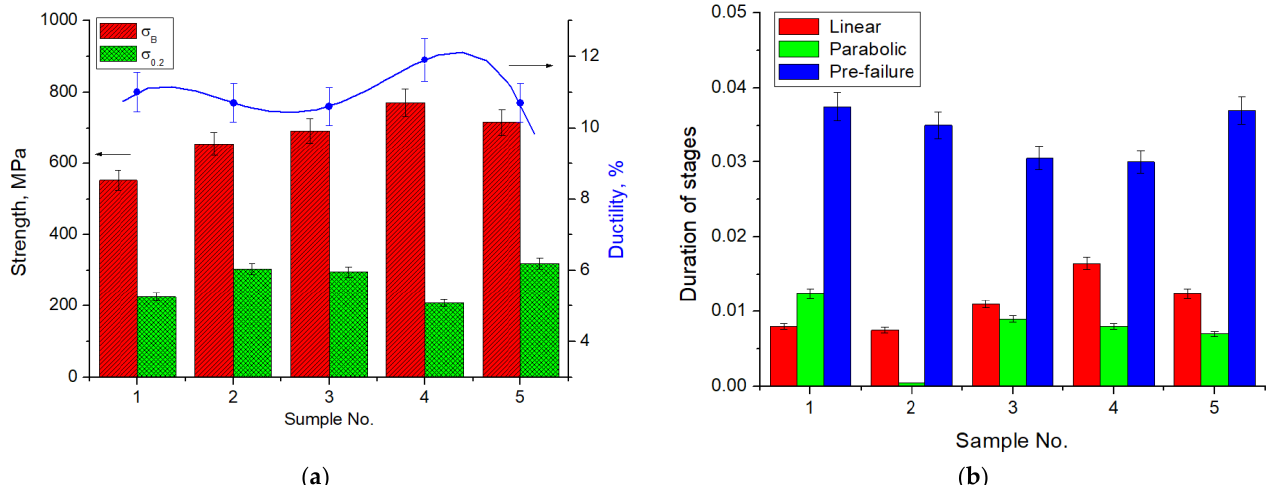
Figure 2. Mechanical characteristics ( a ) and duration of plastic flow stages ( b ) from various zones of the rolling center. The numbers of samples correspond to those from Figure 1.